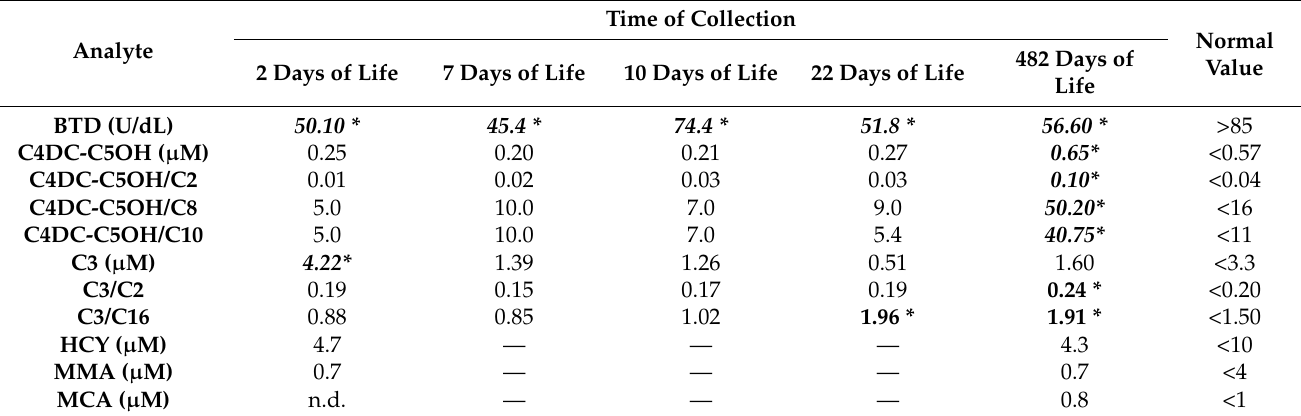
Table 1. Results of newborn screening (NBS) and second-level tests carried out at 2, 7, 10, 22, and 482 days of life. Results in bold and italics characters and with an asterisk indicate positive test results. N.d. means: Not